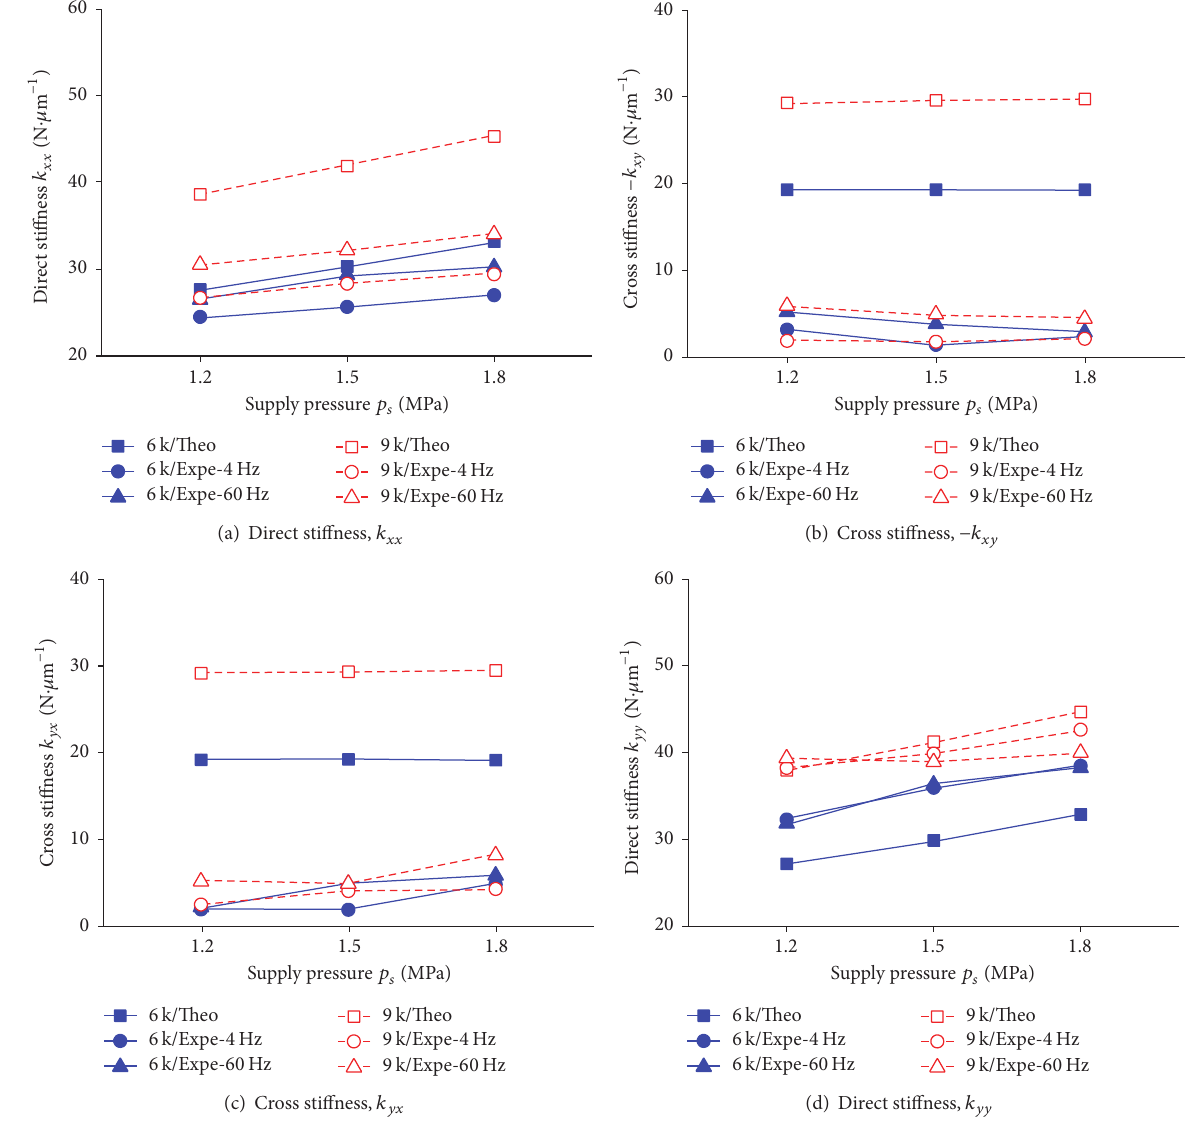
Figure 4: Comparative results of the stiffness coefficients by noncontact harmonic excitation: two rotating speeds (6,000 r/min and 9,000 r/min), three supply pressures (1.2MPa, 1.5 MPa, and 1.8MPa), and two exciting frequencies (4Hz and 60